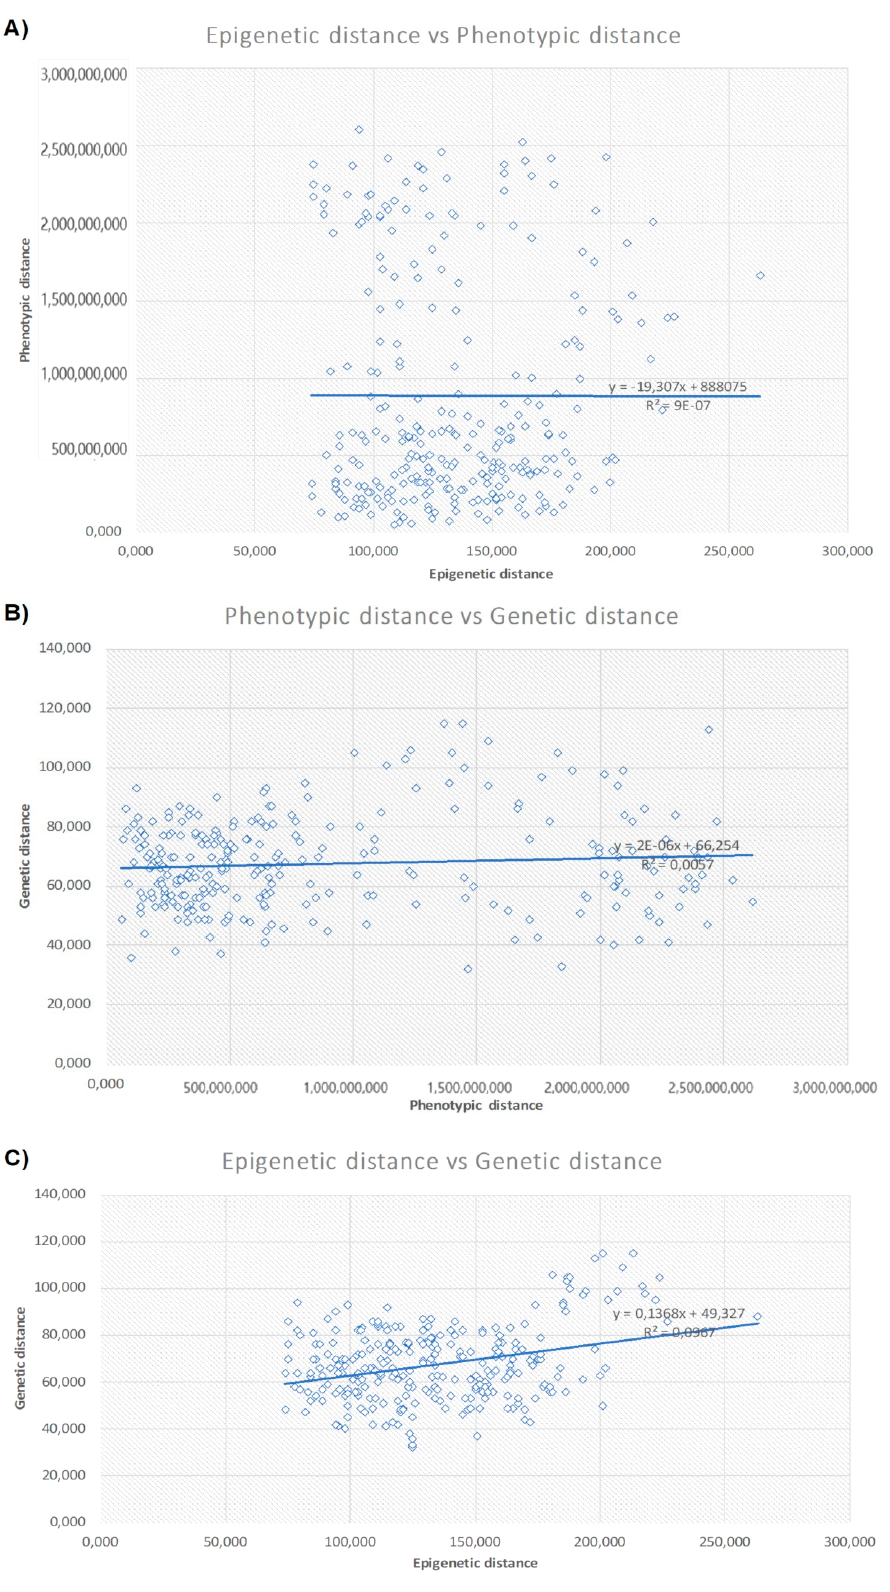
Figure 6. Mantel test for the correlation ( A ) between inter- population epigenetic and phenotypic differentiation, ( B ) between inter-population genetic distance and phenotypic differentiation, and ( C ) between inter-population epigenetic and genetic